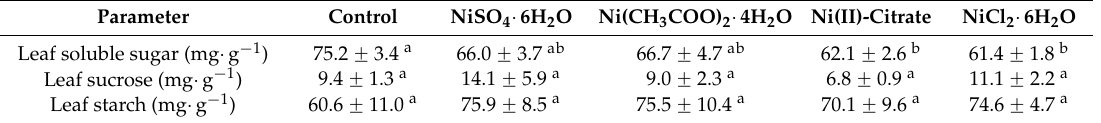
Table 3. Effects of Ni added to the soil (at 560 mg Ni· kg − 1 of soil) as NiSO 4 ·6H 2 O, Ni(CH 3 COO) 2 ·4H 2 O, Ni(II)-citrate, and NiCl 2 ·6H 2 O on the content of leaf soluble sugars, sucrose and starch.